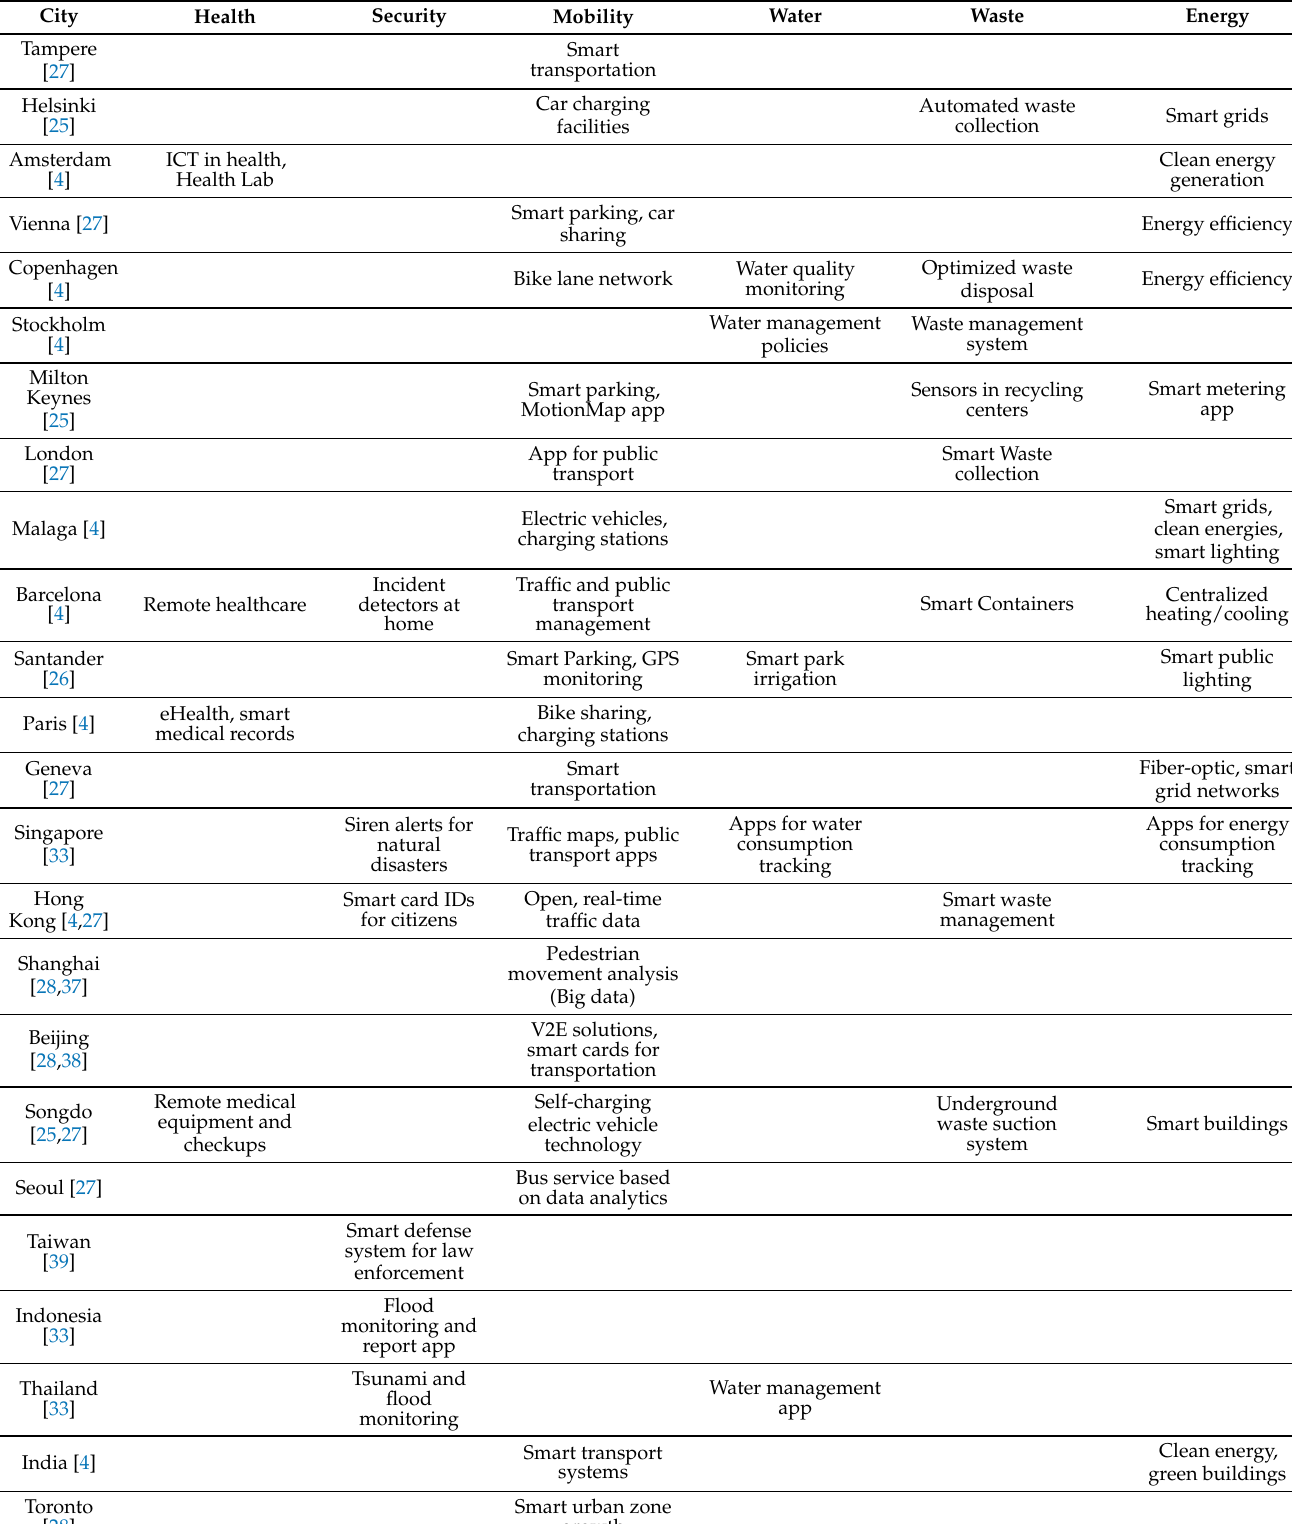
Table 1. Smart cities implementations around the